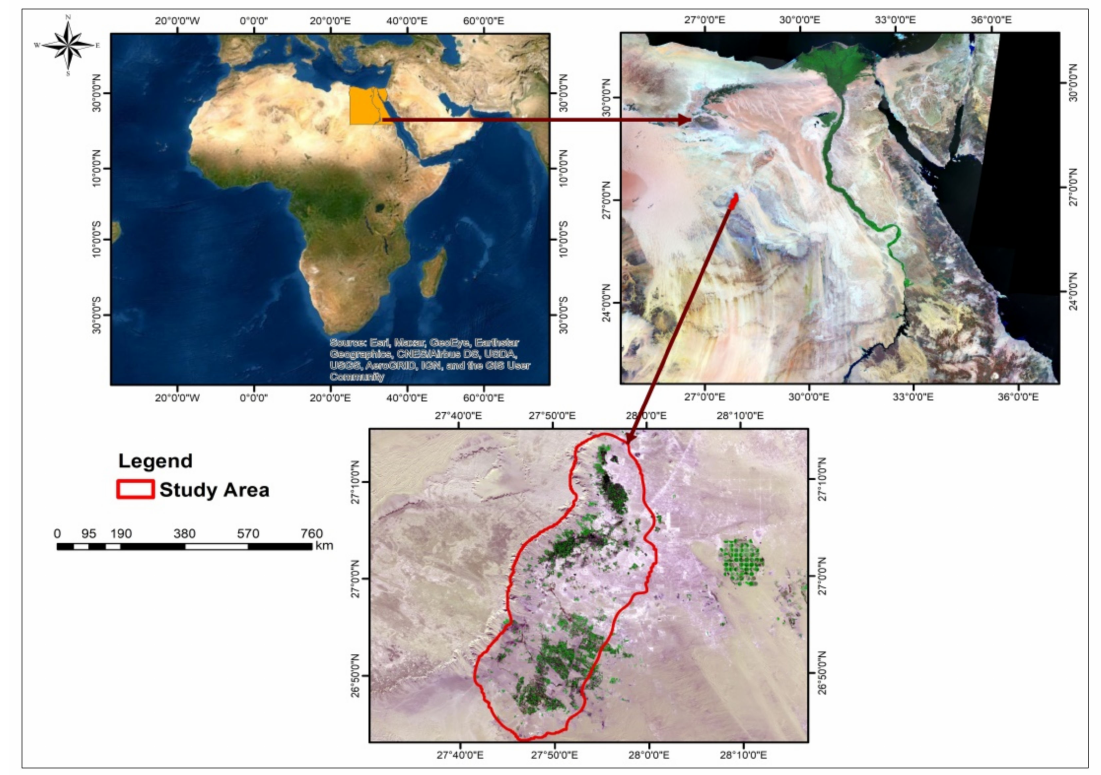
Figure 1. Location maps of the studied area (Sentinel-2A and landsat-8 mosaic